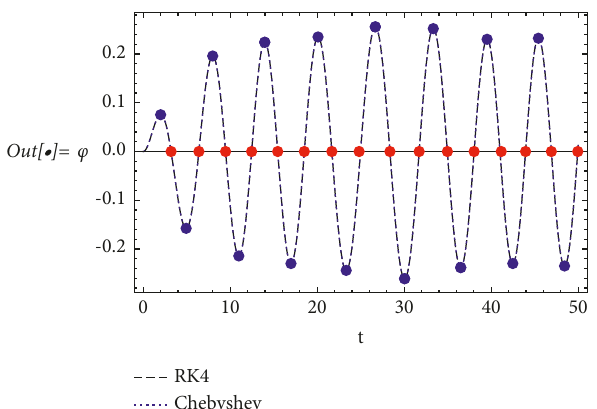
Figure 1: The Chebyshev collocation and RK numerical approximations to i.v.p. (3) for 0 . 2 , 0 . 2 , 1 , 1 , 0 . 2 , 1 , 0 . 1 , 0 , 0 ( minima to the crest and the trough is determined.